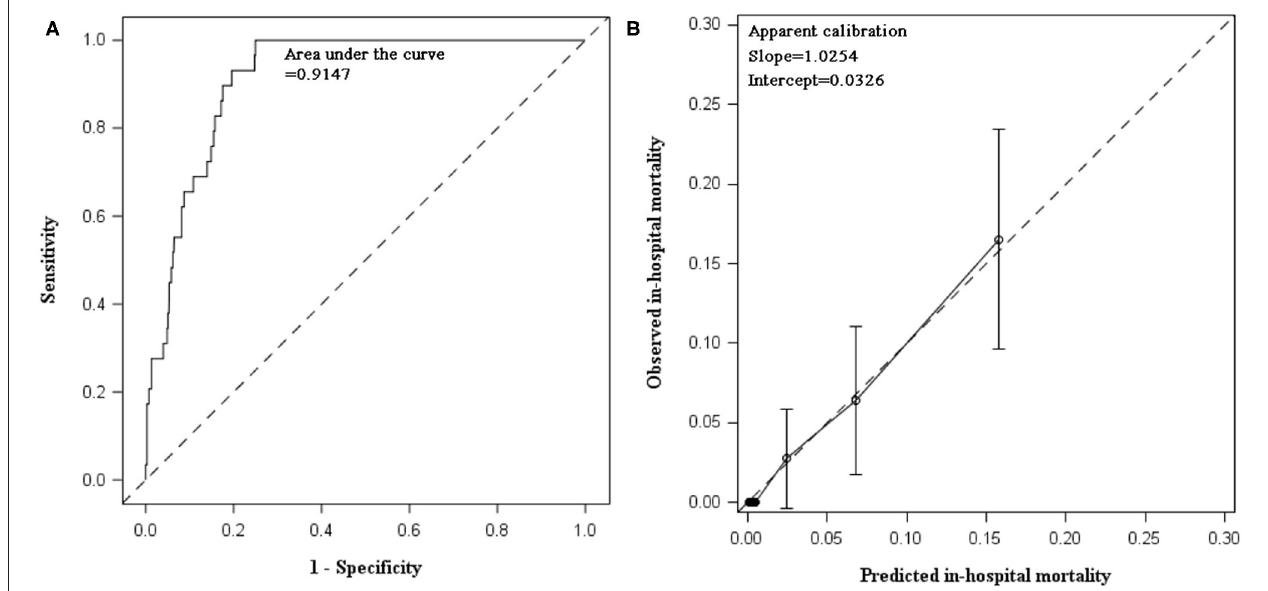
FIGURE 1 | Discimination and calibration of in-hospital mortality prediction model in internal validation using data collected between 2015 and 2017. (A) AUC of prediabetes prediction model: the prediction model demonstrated excellent discrimination. The apparent C statistics and optimism-corrected C statistics were 0.9147 and 0.90887, respectively. After recalibration, C statistics remained the same and the estimate (95% CI) was still 0.9147 (0.8850, 0.9444). (B) Calibration plot of prediction model: calibration slope was 1.0254 (95% CI: 0.7276, 1.3233) and intercept was 0.0326 (95% CI: − 0.7834, 0.8486). Hosmer–Lemeshow test was insignificant (chi-square statistics = 2.6249, df = 8, P =